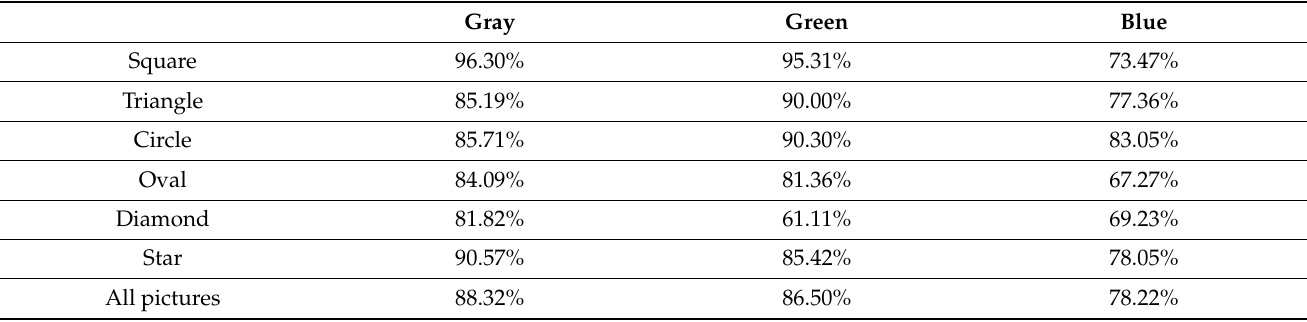
Table A22. Accuracy of the baseline (AlexNet with SVM) for all geometries in three